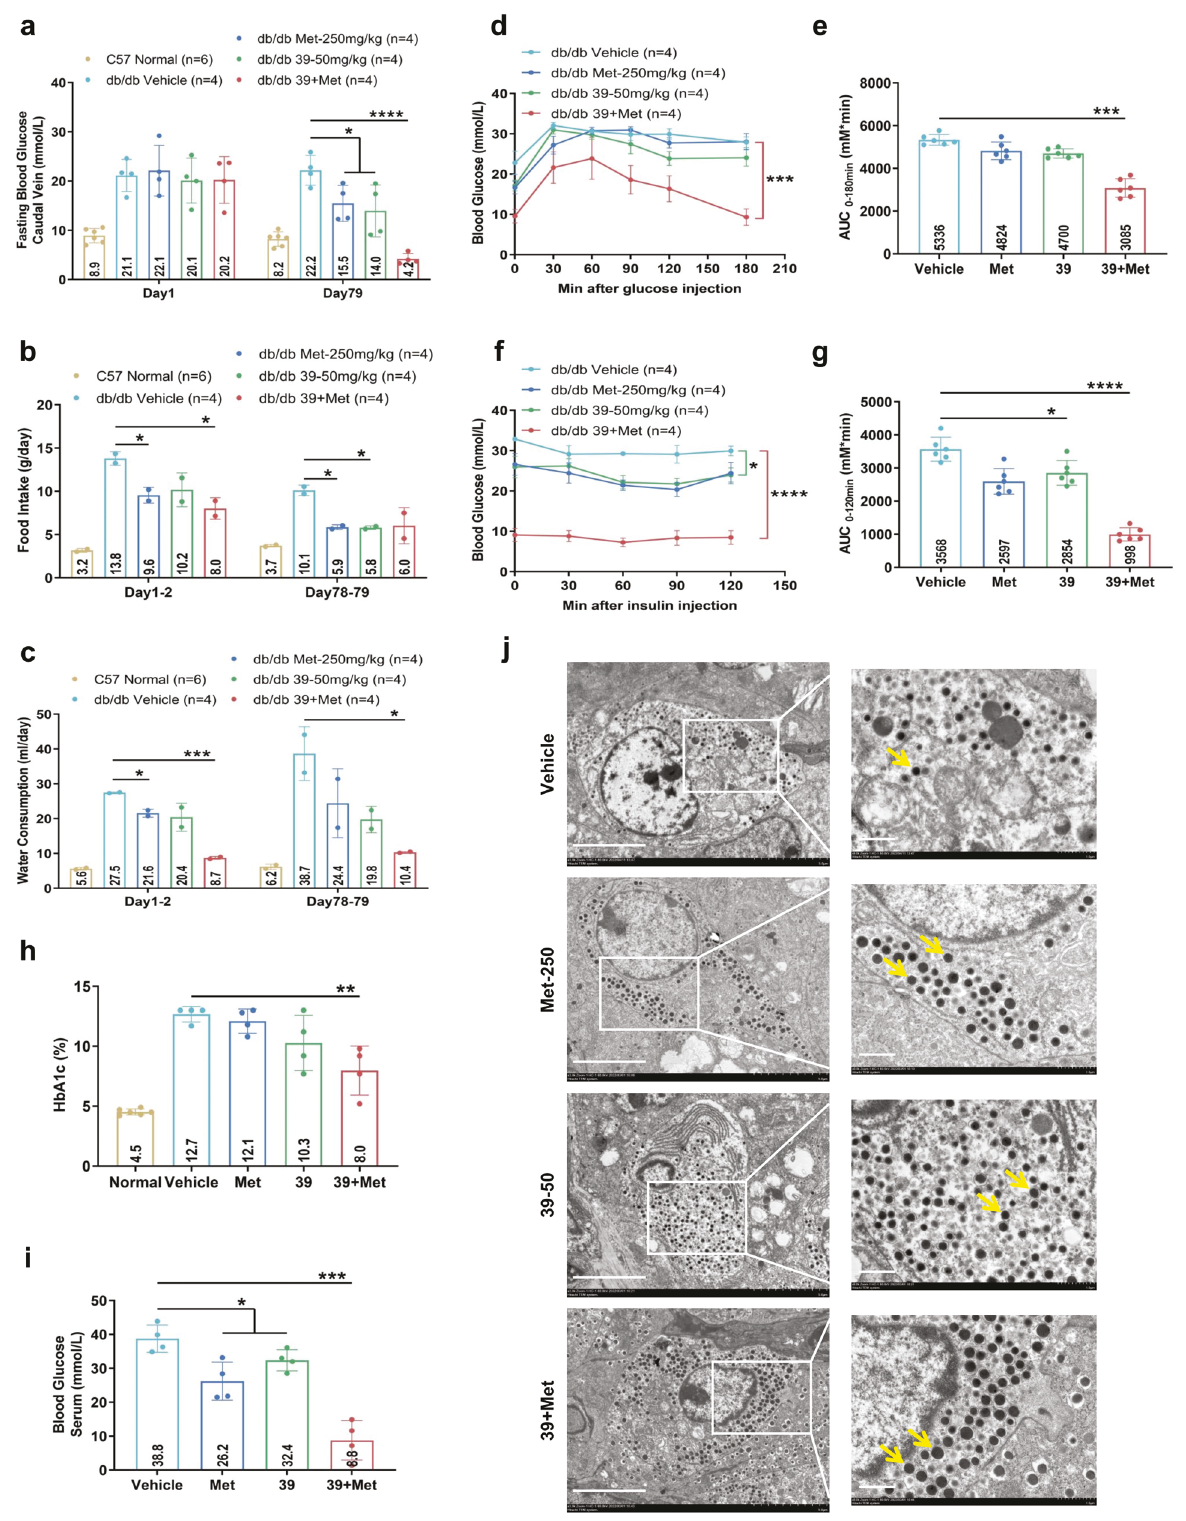
Fig. 5 Combination of IHMT-MST1-39 and metformin prevents diabetic hyperglycemia in obese db/db mouse model of T2D. a – c Fasting blood glucose, food intake and water consumption measurements for once a week. d , e Intra-peritoneal glucose tolerance test (IPGTT) measured during 0 min and 180 min after glucose injection. Respective area-under-the-curve (AUC) shown in e . f , g Intra-peritoneal insulin tolerance test (IPITT) performed during 0 min and 120 min post insulin injection. Respective area-under-the-curve (AUC) shown in g . Data were expressed ±SEM. * p < 0.05 IHMT-MST1-39 to vehicle control; P values determined by Student ’ s t test. h , i HbAc1 and blood glucose (serum) level was measured by Chemray-240/800. Data were expressed ±SEM. * p < 0.05, IHMT-MST1-39 compared with vehicle group mice; P values determined by Student ’ s t test. j Isolated pancreases from db/db mice, islets activity was analyzed by cryo-sections of pancreases (as yellow arrow shows, black circles represent insulin), Scale bar, 5 μ m (left), 1 μ m (right) Signal Transduction and Targeted Therapy (2023)